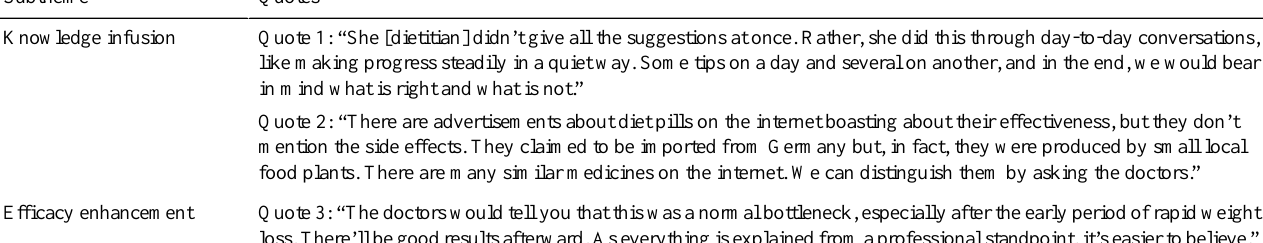
Table 1. Supporting quotes for theme 1: Professionally led support for capacity building.